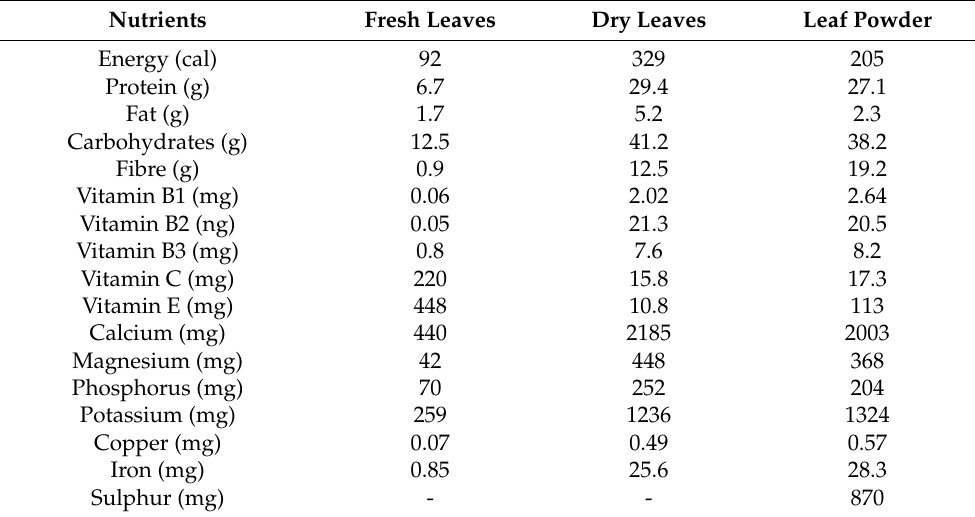
Table 1. The nutrient composition of Moringa oleifera fresh leaves, dry leaves, and leaf powder. Nutrients Fresh Leaves Dry Leaves Leaf Powder Energy (cal) 92 329